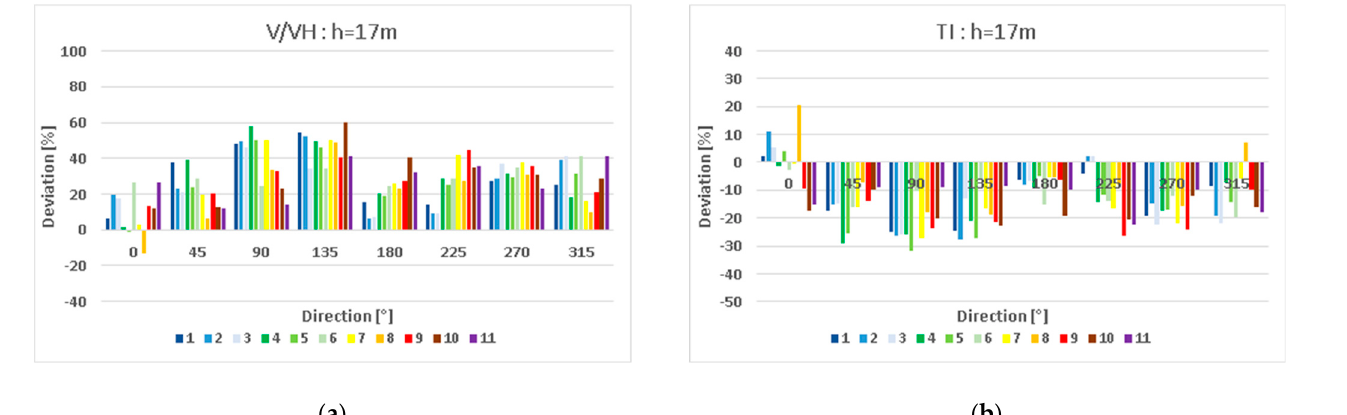
Figure 19. Mean absolute deviations of the wind ( a ) and turbulence intensity ( b ) per direction for the 11 probe validation points at height h = 17 m with WAsP Engineering.